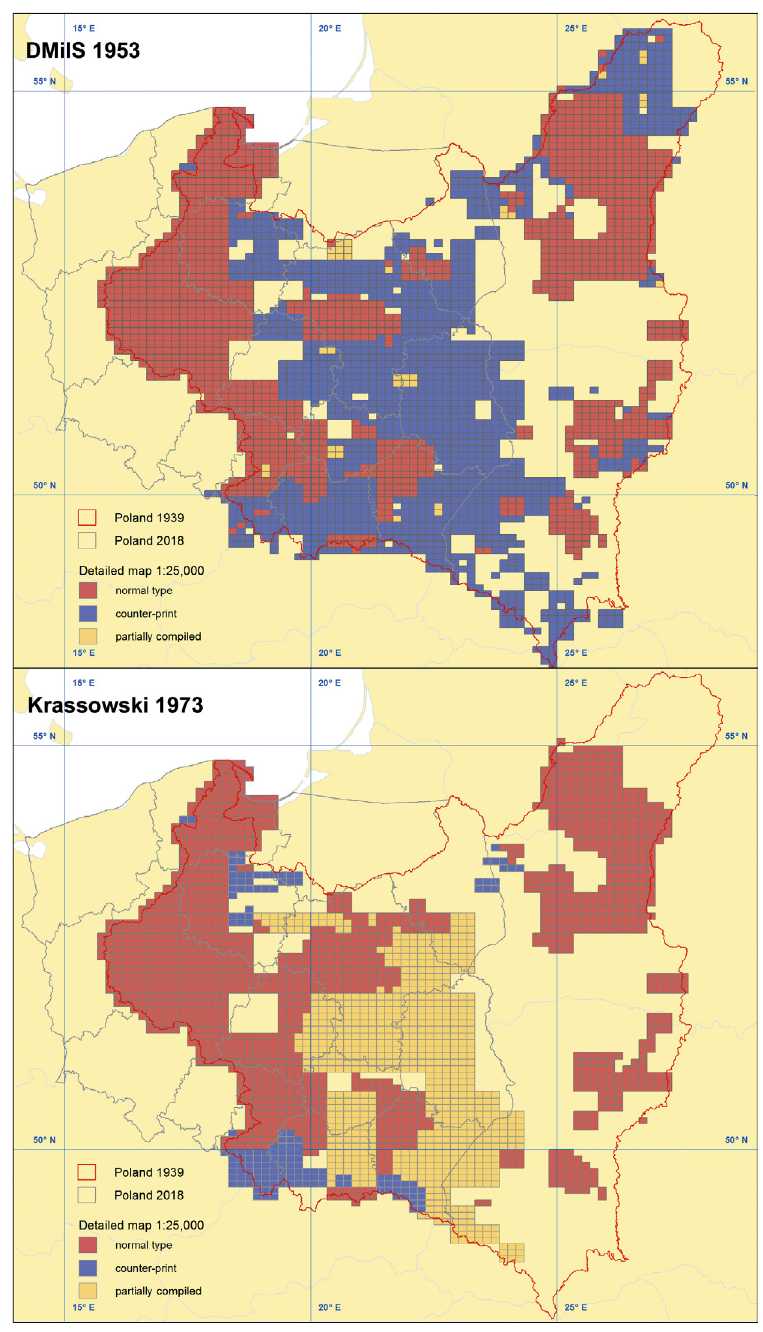
Fig. 2. MGI’s 1:25,000 detailed map sheet types according to different sources (Author’s original